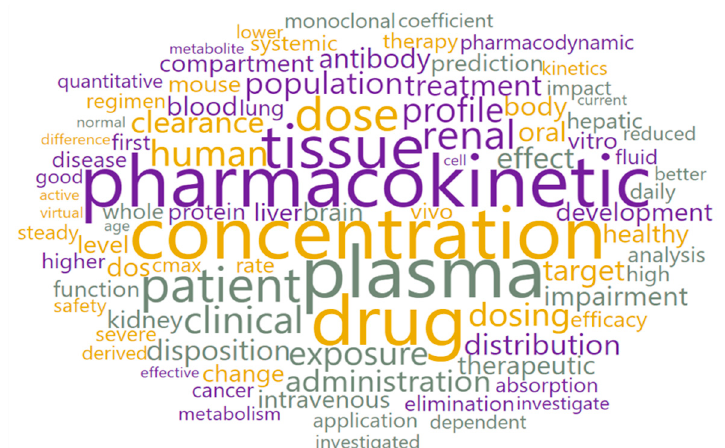
Figure 9. Word cloud for topic 2.